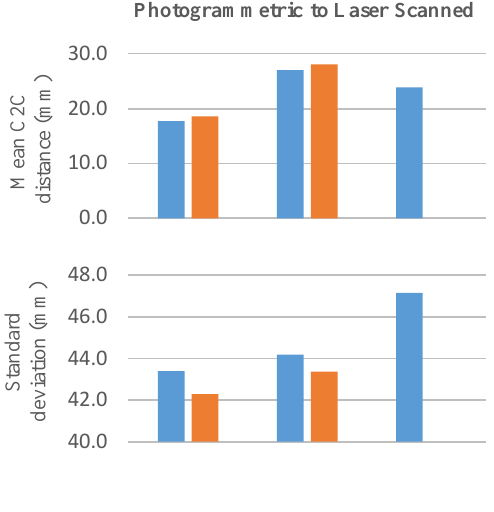
Figure 11. C2C distances of Photoscan point clouds with photoset 1 (left) and 2 (right). Red indicates 5cm and